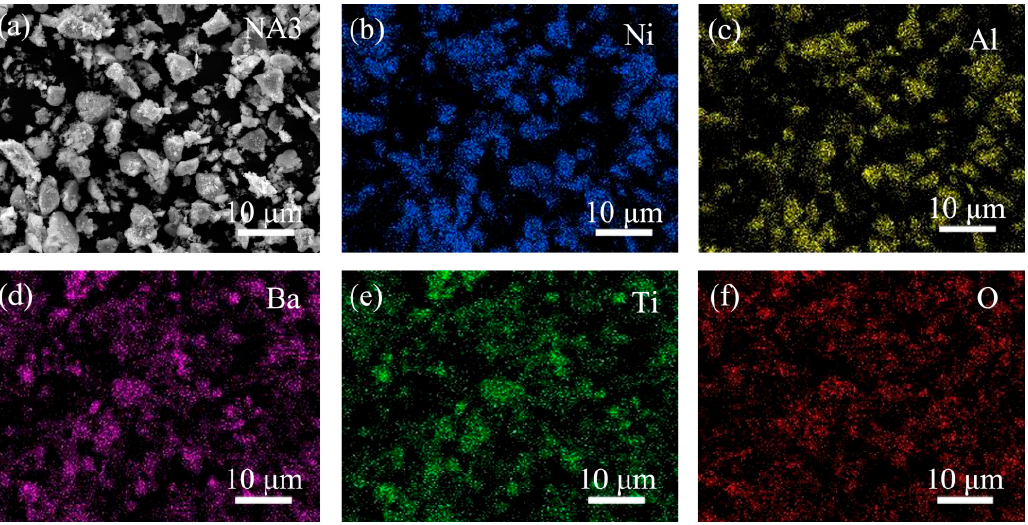
Figure 1. Morphology of mixed powders by ball milling: ( a ) SEM morphology; ( b ) Ni; ( c ) Al; ( d ) Ba; ( e ) Ti; ( f ) O.